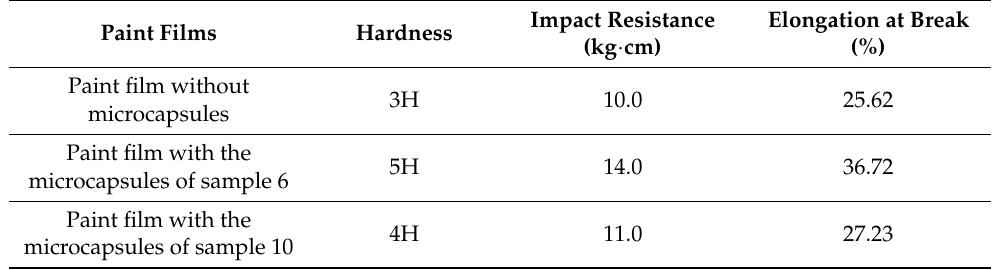
Table 8. Mechanical properties of paint films prepared by microcapsules of different wall